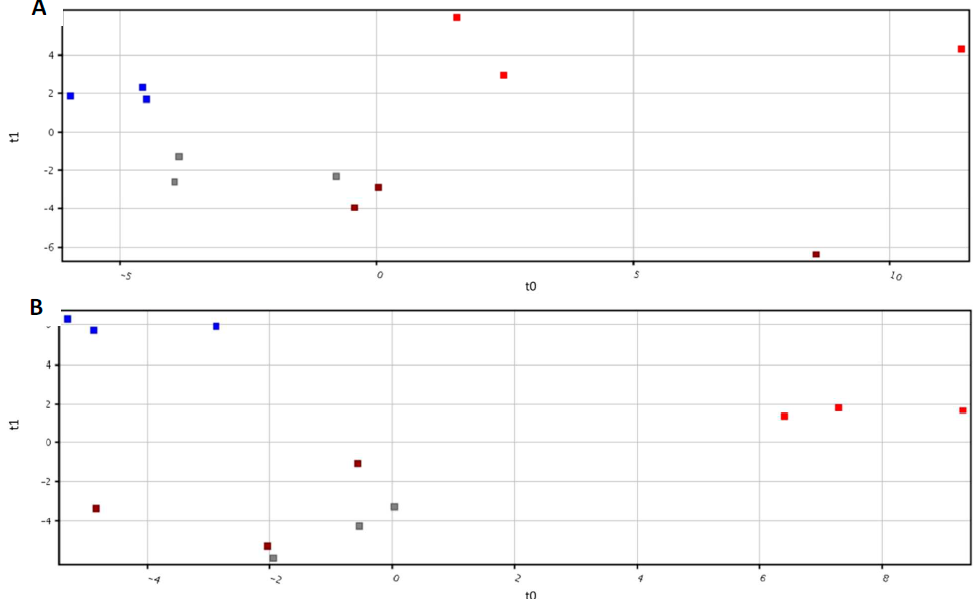
Figure 3. Partial Least Squares Discriminant (PLS-DA) multivariate modelling from the dataset obtained through GC-MS ( A ) and UHPLC / QTOF-MS ( B ) analysis in the root exudates of plants exposed to the di ff erent nutritional conditions (Grey = Control, Blue = Fe deficiency, Brown = S deficiency, Red = dual deficiency).